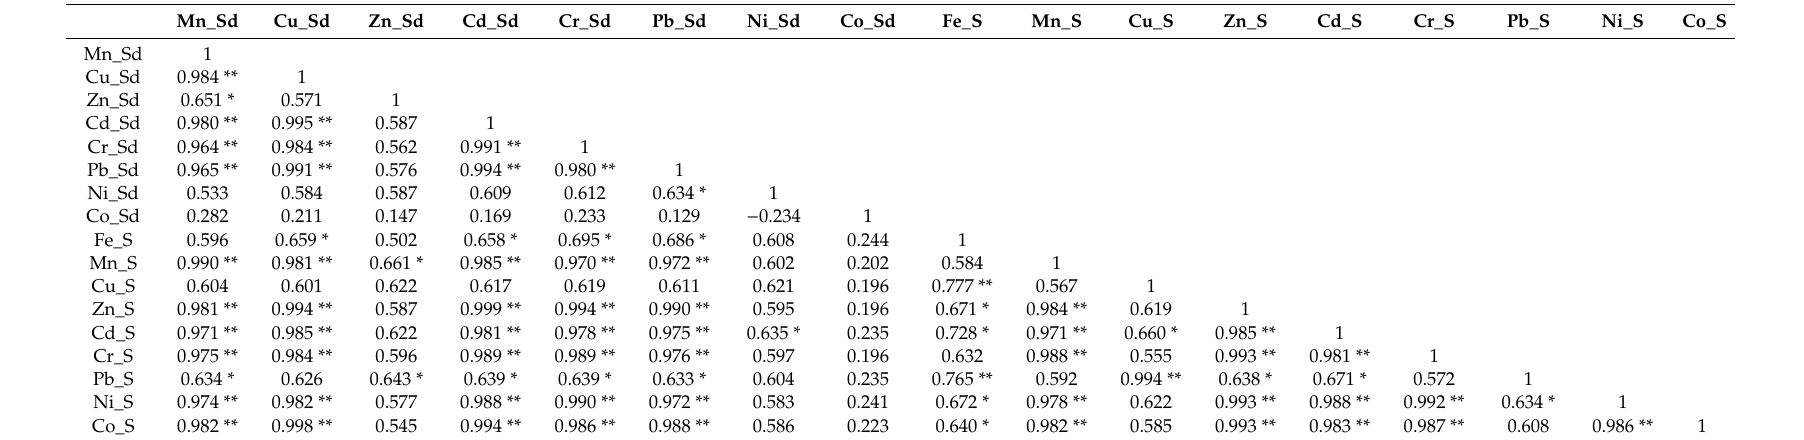
Table 4. The correlation coe ffi cient between metals in sediments and freshwater